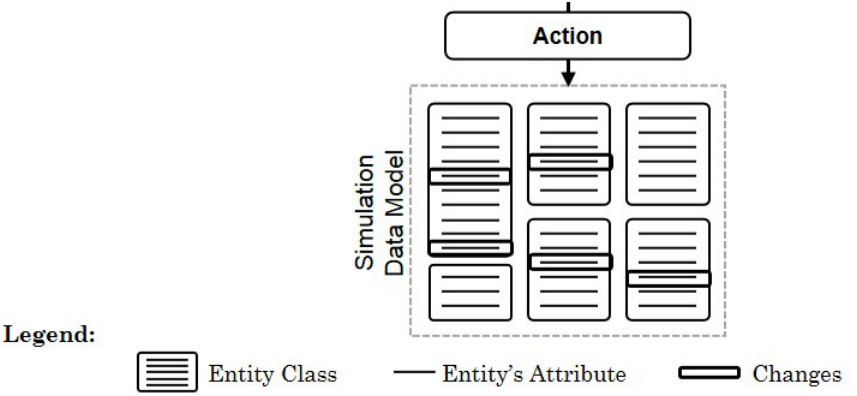
Figure 2. Applying an action directly to the simulation’s database.